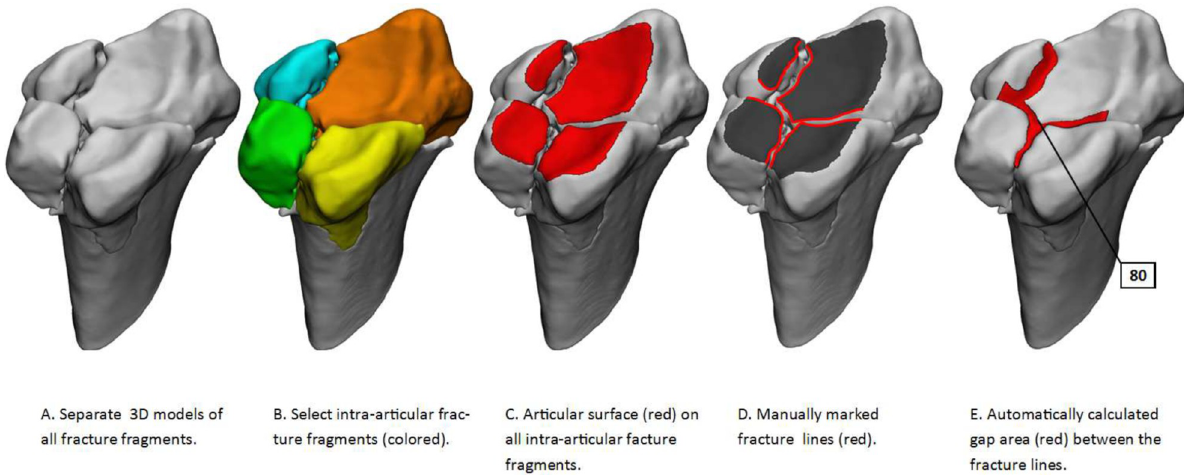
Fig 2. 3D gap area measurement (= 80 mm 2 ) illustrated on the 3D models (volar view with 45 degrees tilt towards volar/ulnar side) of patient 7. A: 3D model of the fractured wrist; B: All fragments are randomly assigned different colors (all four are intra articular in this case.); C: The articular surface is marked red on all intra-articular parts; D: Fracture lines in the articular surface are marked red; E: The gap area (red) was automatically calculated between the fracture lines.